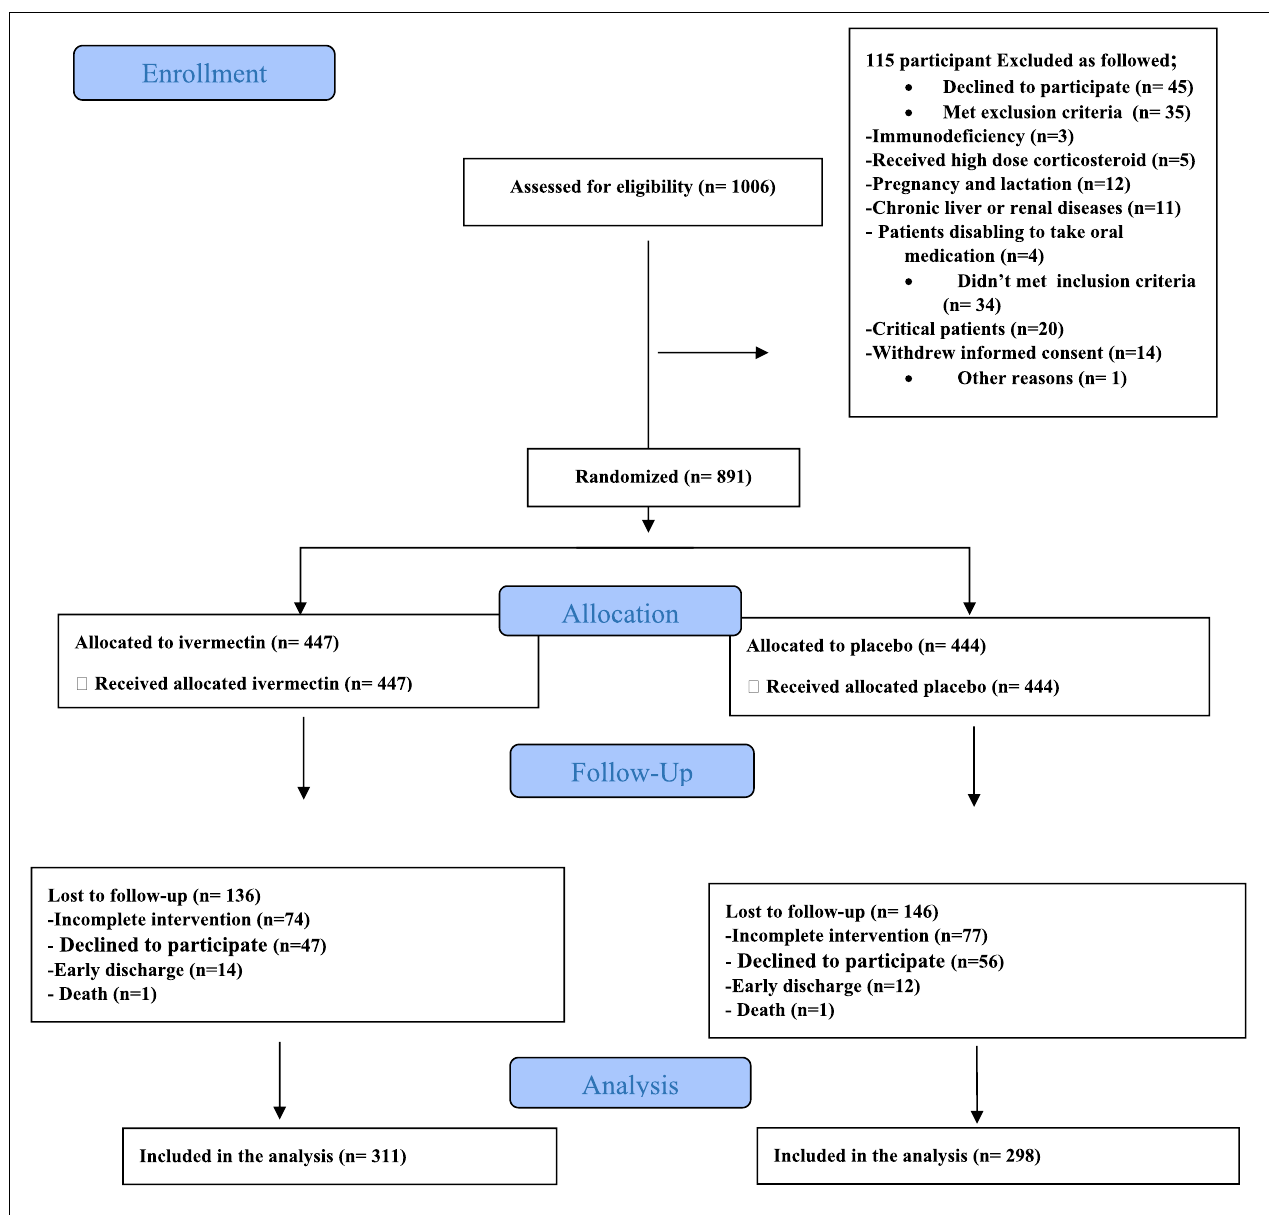
FIGURE 1 | Enrollment, allocation, follow up and assignment of